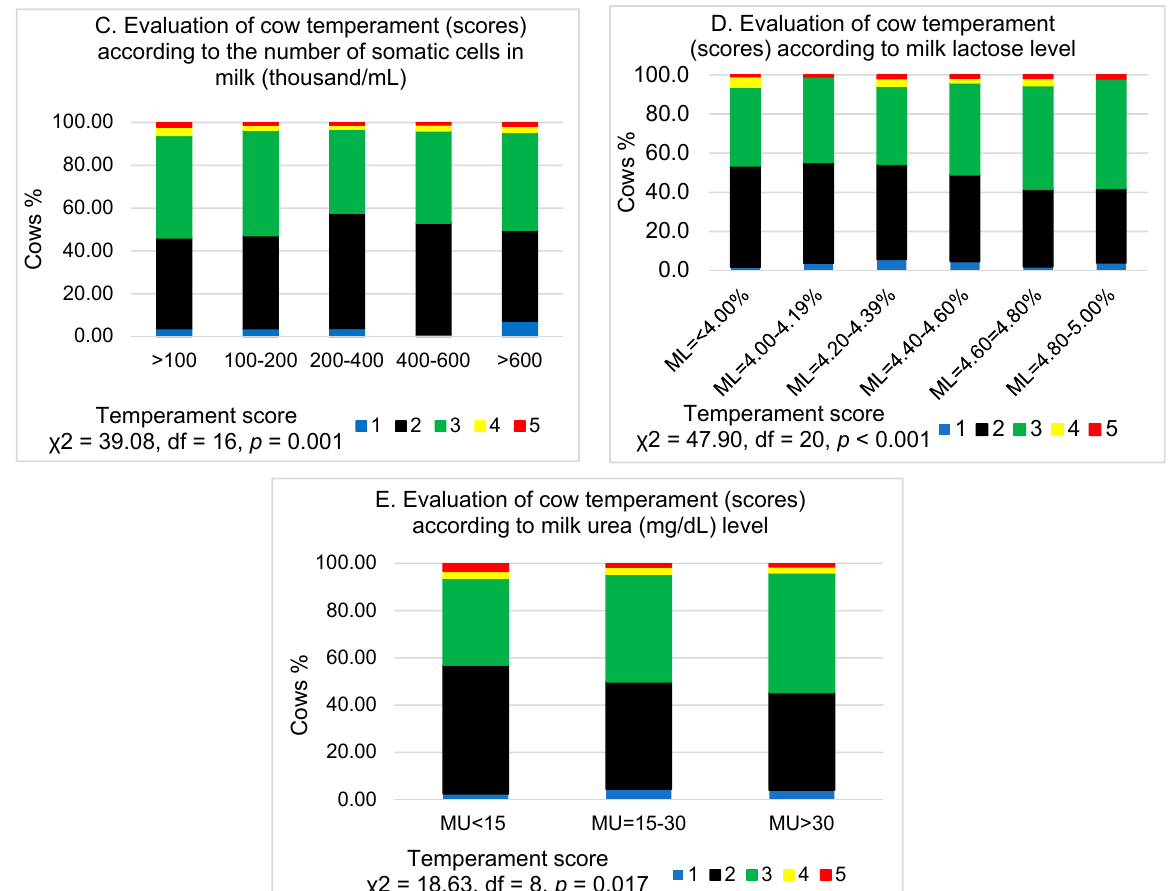
Figure 2. Evaluation of cow temperament scores according to milk indicators. F/P—milk fat-to-protein ratio; ML—milk lactose (%); MU—milk urea (mg/dL); SCC—milk somatic cell count (thousand/mL). ( A ) Evaluation of cow temperament (scores) according to milk yield; ( B ) Evaluation of cow temperament (scores) according to milk fat-to-protein ratio; ( C ) Evaluation of cow temperament (scores) according to the number of somatic cells in milk (thousand/ml); ( D ) Evaluation of cow temperament (scores) according to milk lactose level; ( E ) Evaluation of cow temperament (scores) according to milk urea (mg/dL) level. 1—very slow–very calm; 2—slow–calm; 3—normal; 4—sensitive–aggressive; 5—very sensitive– very aggressive.